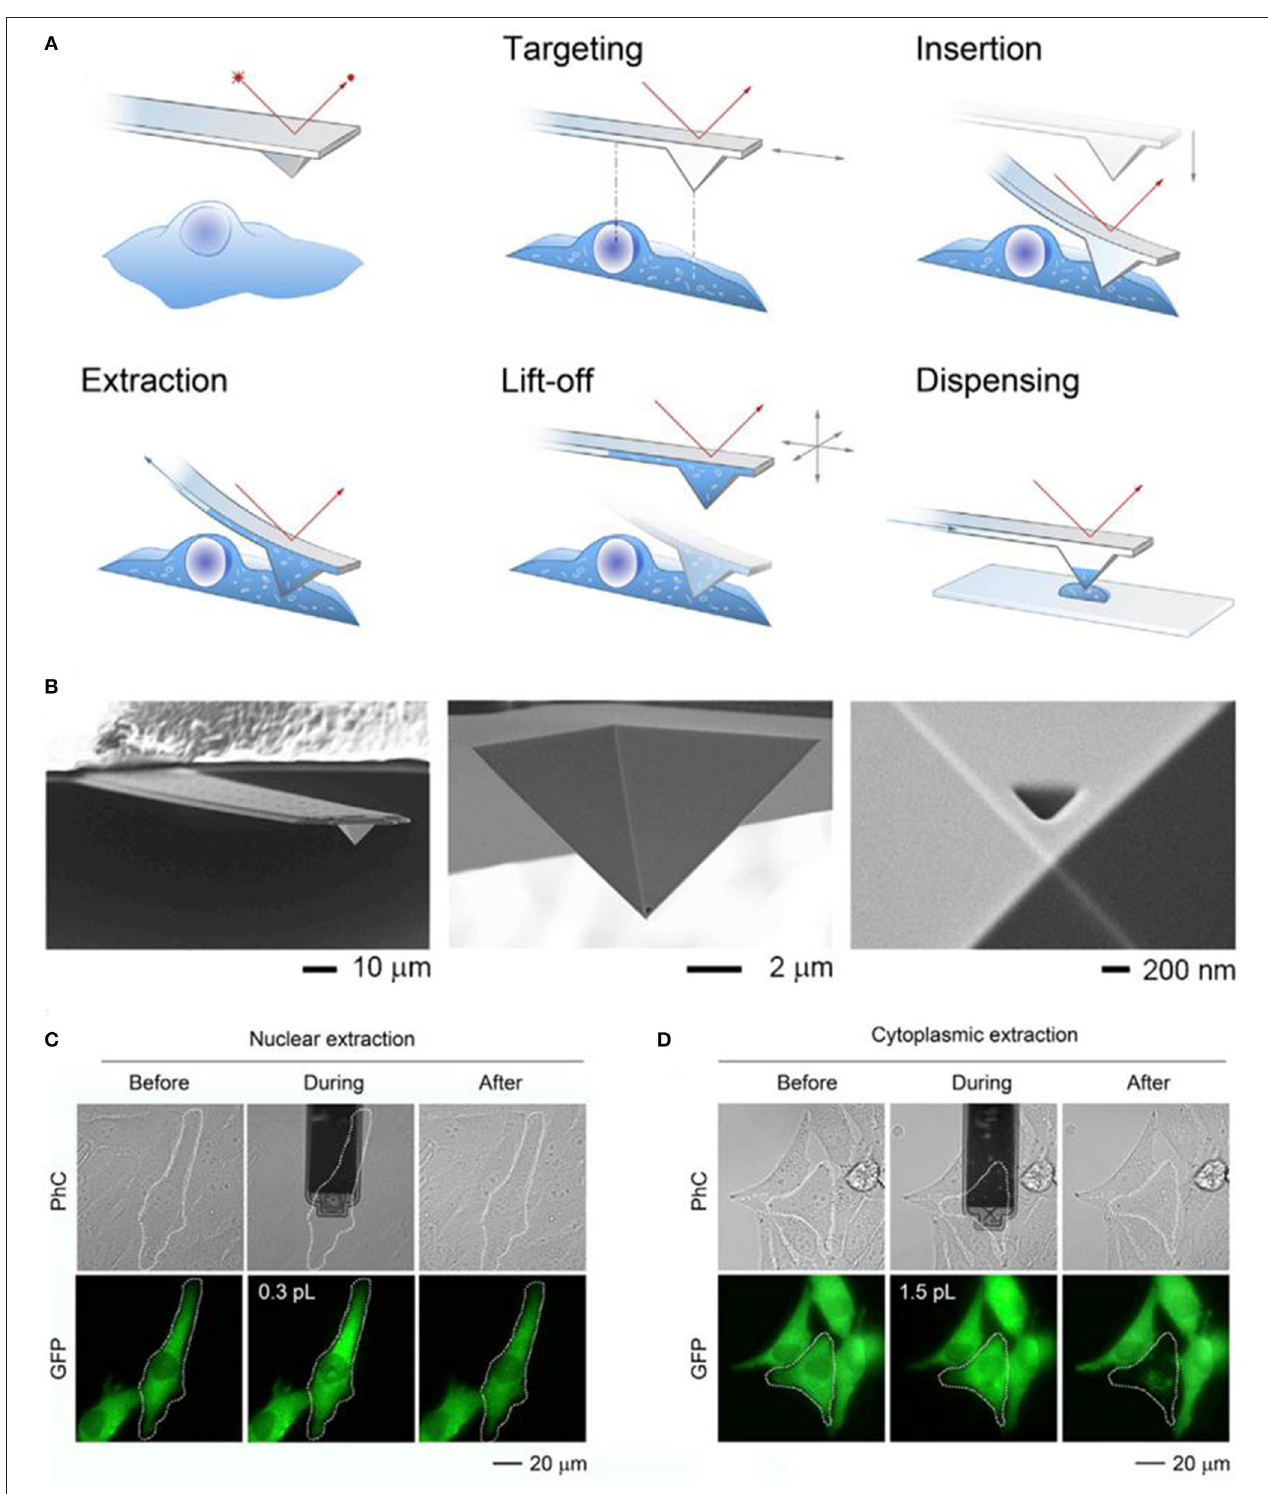
FIGURE 2 | Schematic of the FluidFM based extraction procedure (A) and SEM image of a FluidFM probe (B) ; phase-contrast (PhC) and fluorescent images with GFP of representative extracts from the nucleus (C) and cytoplasm (D) of the target cells.